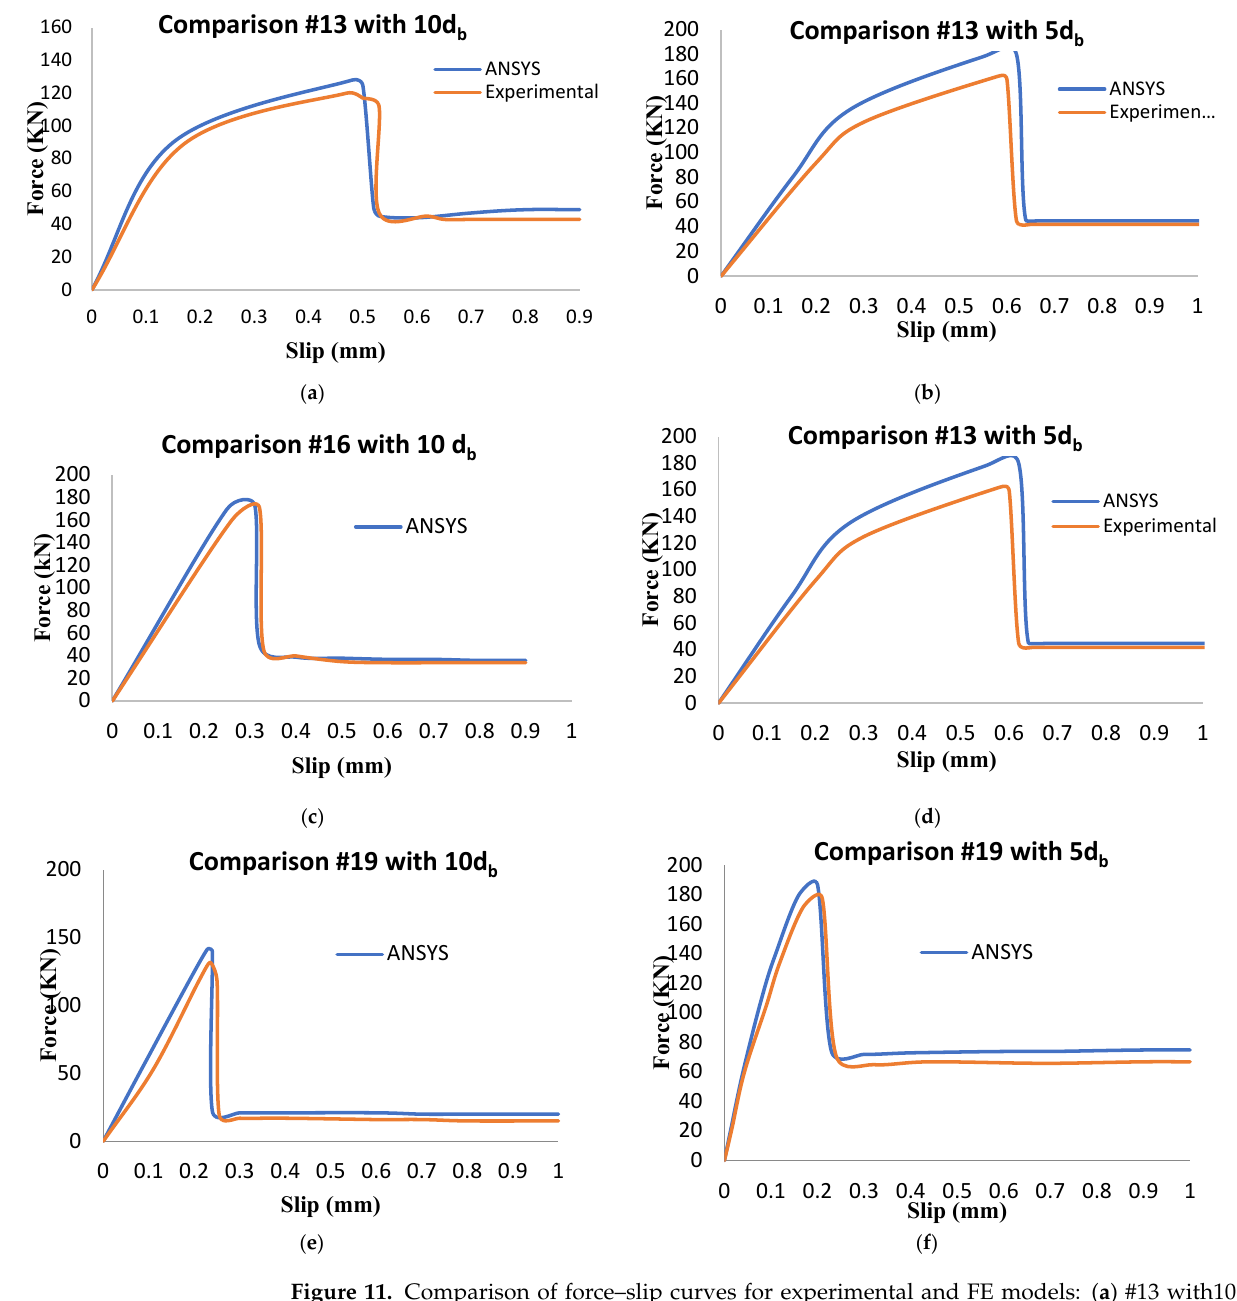
Figure 11. Comparison of force–slip curves for experimental and FE models: ( a ) #13 with10 db; ( b ) #13 with 5 db; ( c ) #16 with 10 db; ( d ) #16 with 5 db; ( e ) #19 with1 0 db; ( f ) #19 with 5 db.